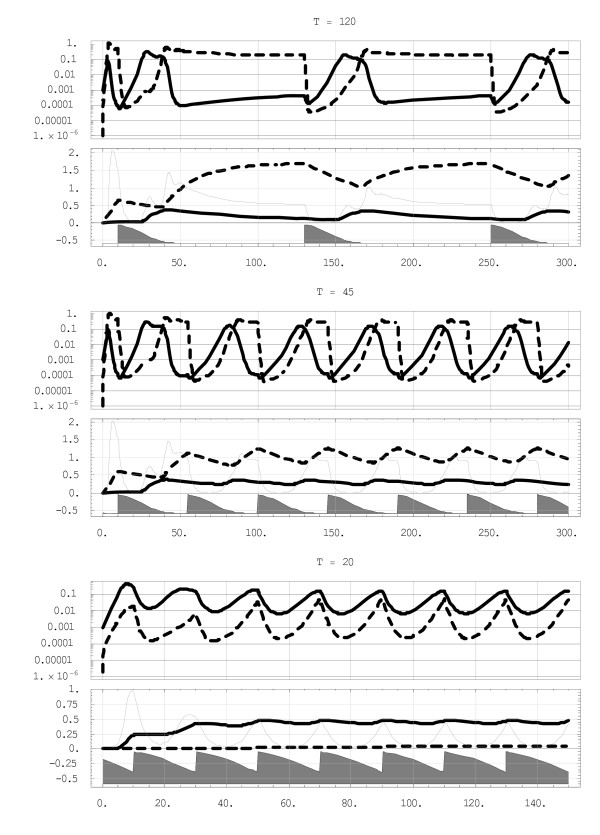
Effect of periodic treatment on inter-strain competition. The outcomes vary from long periods of 'y-domination' (top), to a coexistence pattern (middle) to persistent 'x-domination' (bottom). The upper plot has relatively short windows of 'x-domination', the lower one has persistent 'dominant x' by 1 or 2 orders of magnitude over y. The treatment cover is shown as gray areas; curve marking and axes are the same as Figure 4.